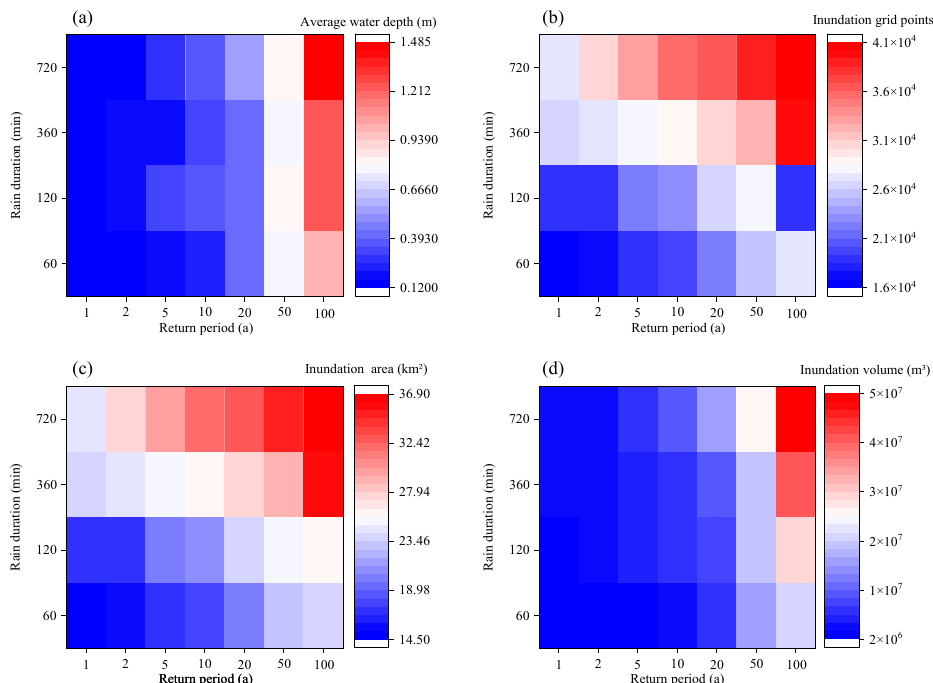
Figure 13. ( a ) The relationship between the average submerged water depth, the return period and duration of rainfall. ( b ) The relationship between the number of submerged grid points and the rainfall return period and rainfall duration. ( c ) The relationship between submerged area and rainfall return period and rainfall duration. ( d ) The relationship between submerged water volume and rainfall return period and rainfall duration.